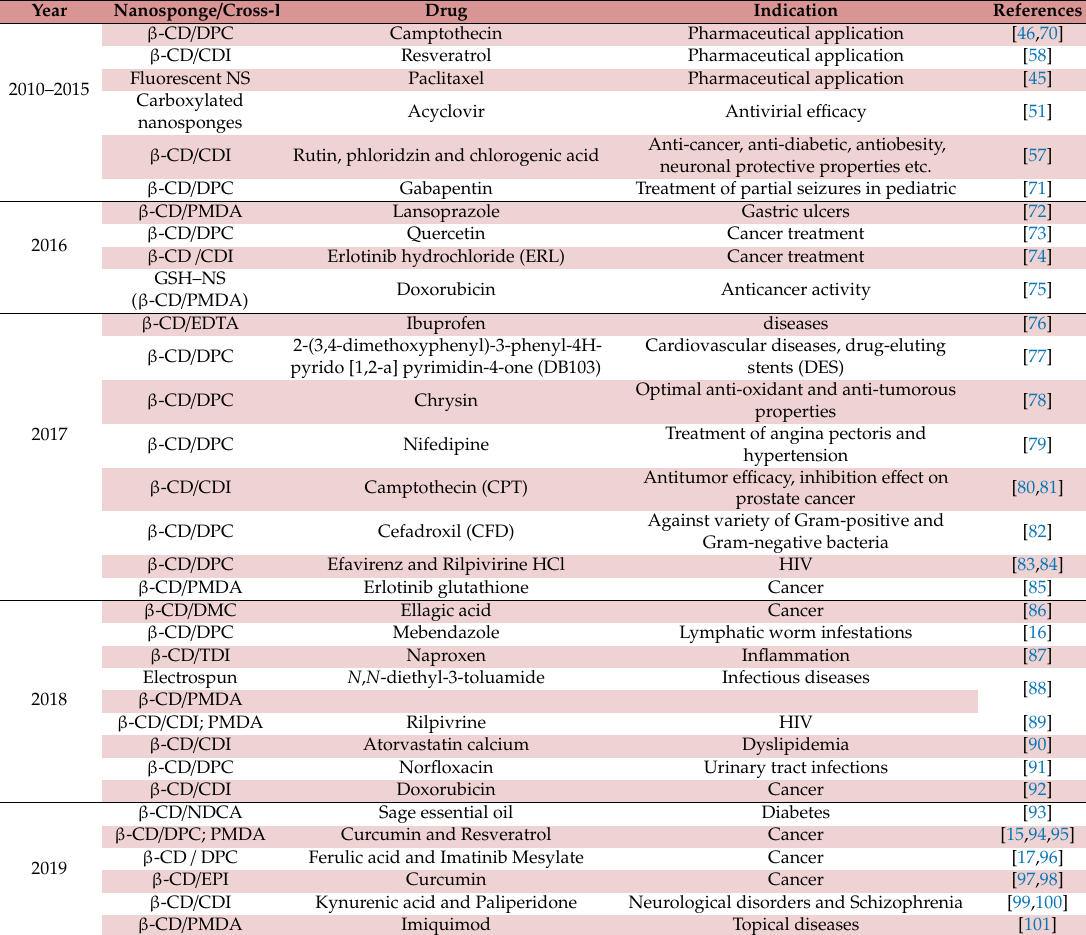
Table 1. Historical excursus of publications on CD-based NSs employed in pharmaceutical